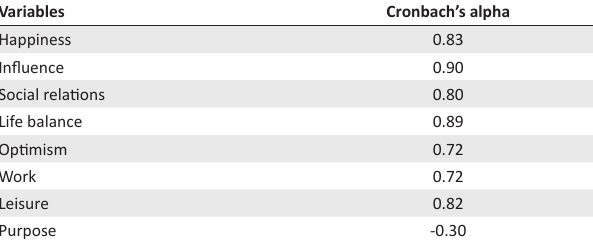
TABLE 1: Cronbach’s alpha coefficients of happiness